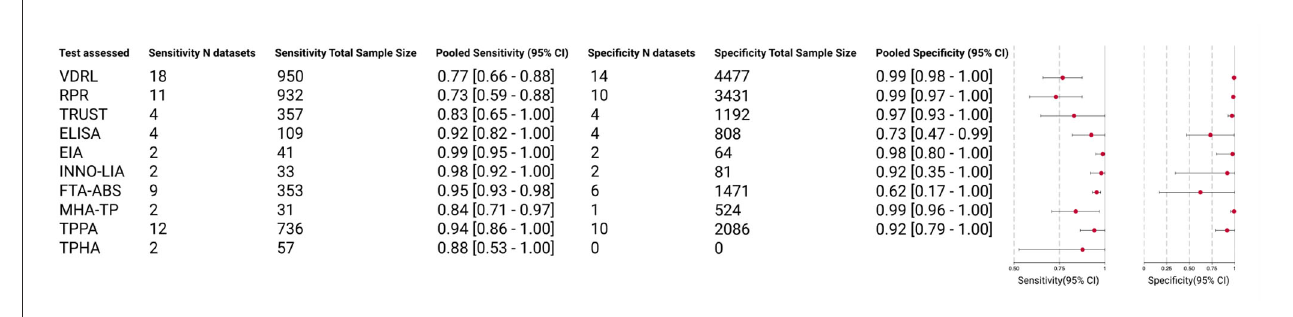
FIGURE4 Clinical accuracy of 3 nontreponemal tests and 7 treponemal